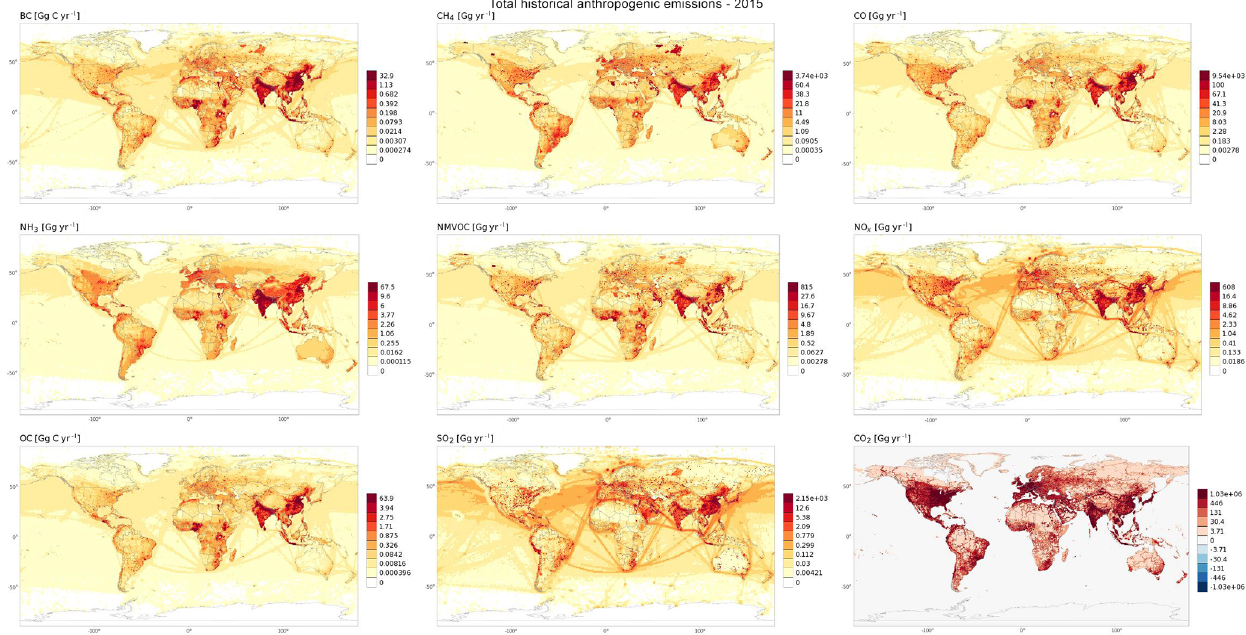
Figure 6. Total anthropogenic emissions in 2015 by species. The color scale is the same for each emission species across all gridded figures for comparison. The CO 2 color scale accommodates the net negative emissions found in some future